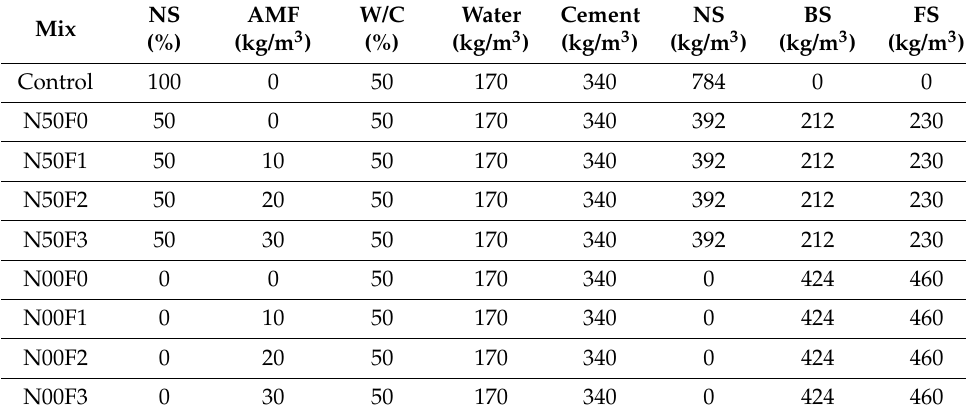
Table 2. Mix proportions of cement